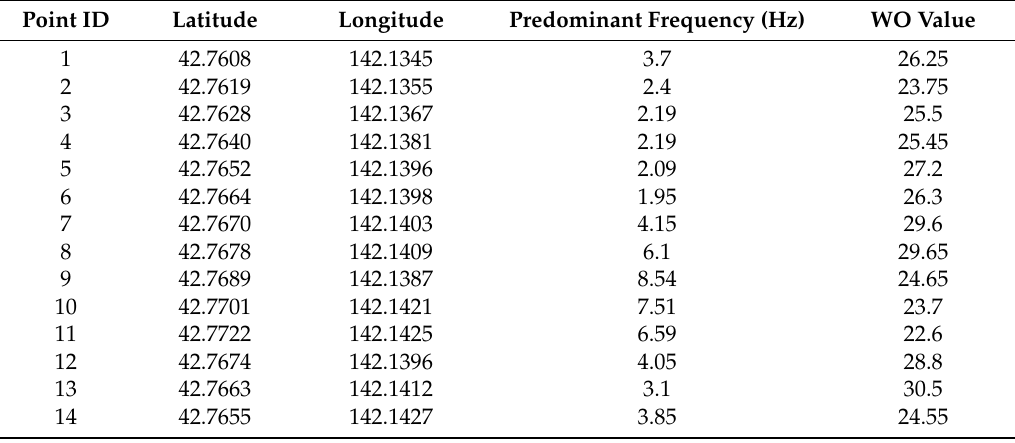
Figure 8. ( a , b ) H / V spectra measured at 14 point locations in Hobetsu; ( c ) fluctuations of predominant frequencies and WO values of 14 points in Hobetsu; and ( d ) fluctuations of predominant frequencies and elevations of 14 points in Hobetsu. Table 2. Predominant frequency and WO values of 14 observation points in Hobetsu.